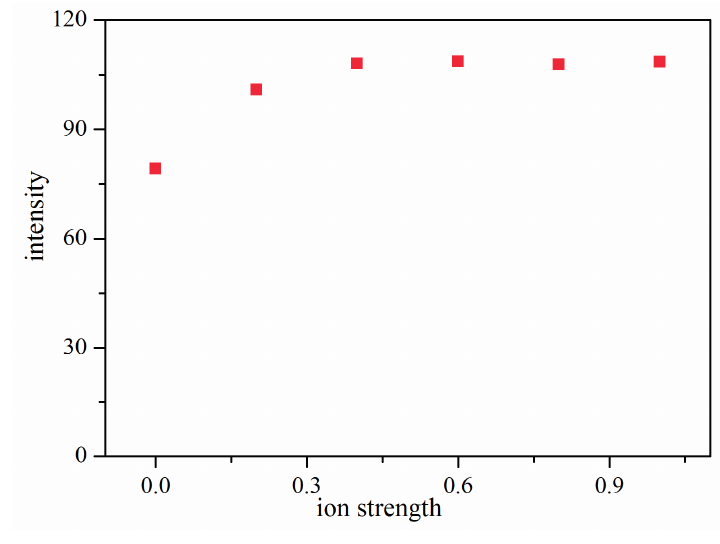
Figure 4. Effect of ion strength on extraction efficiency.